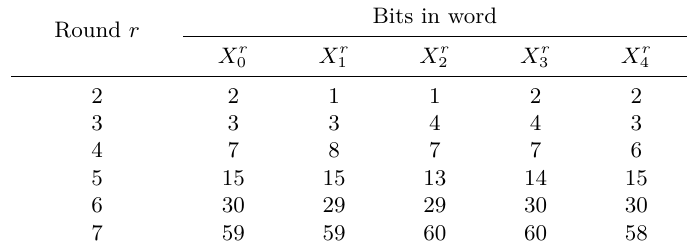
Table 3: Upper bounds on the algebraic degree of Ascon in cube variables Round